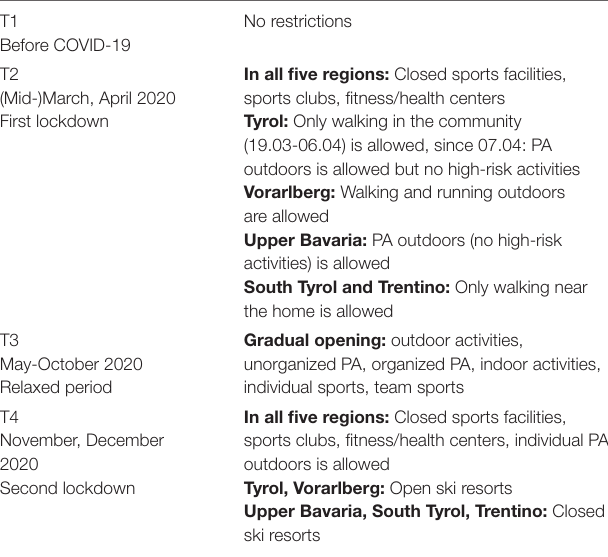
TABLE 1 | Overview of restrictions regarding PA regulations before and during the COVID-19 pandemic in 2020 (simplified presentation of regulations) (84–88). T1 Before